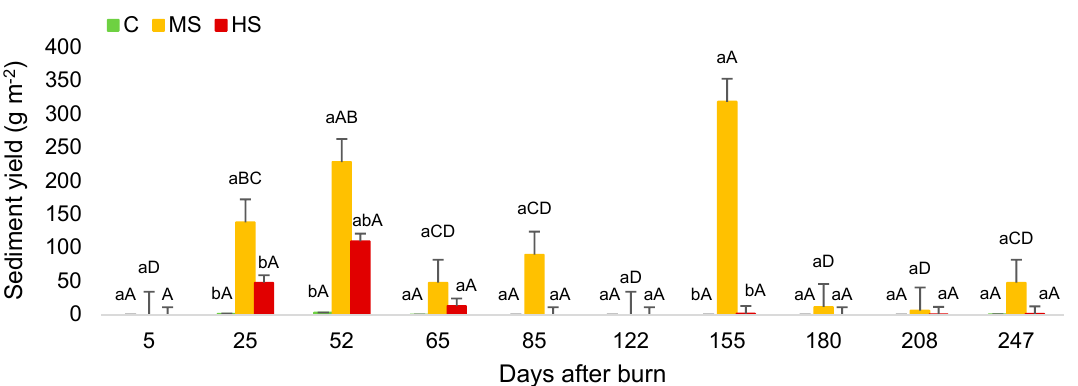
Figure 3. Treatment effect under control (C), moderate severity (MS), and high severity (HS) burn on sediment yield (g m − 2 ) between 5 and 247 days after pile burning. Mean values followed by the different lowercase letters show significant differences within the same date. Mean values followed by the different uppercase letters show significantly different within the same treatment. Significant differences were observed at p < 0.05 . Hanging bars represent the standard error. ( n = 5).